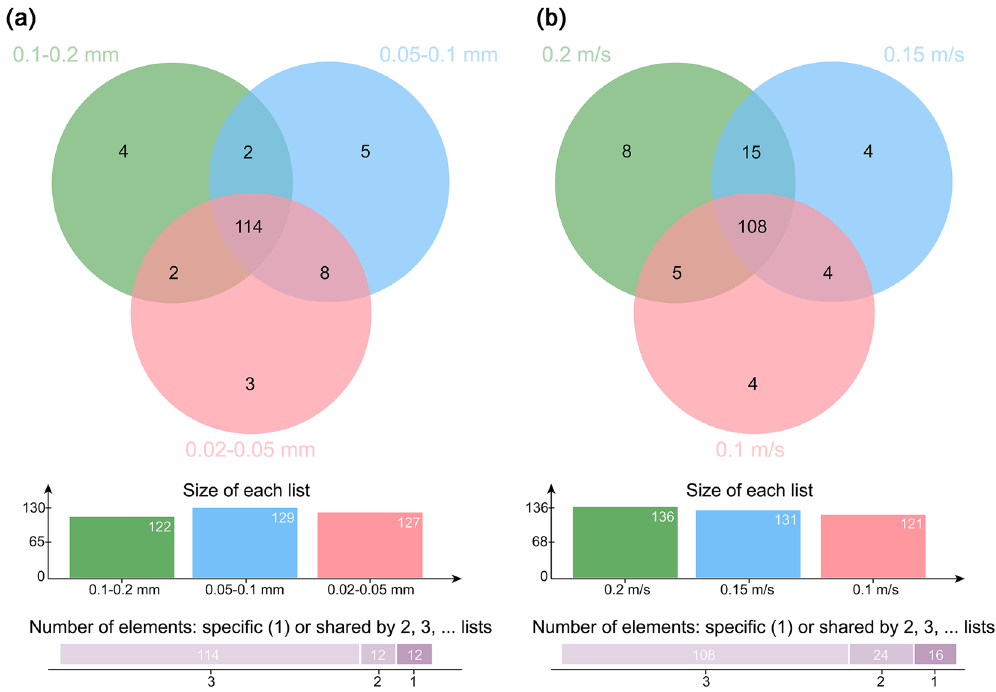
Figure 7. Venn diagrams of the microbial communities at the genus level under ( a ) static, and ( b ) dynamic water flow